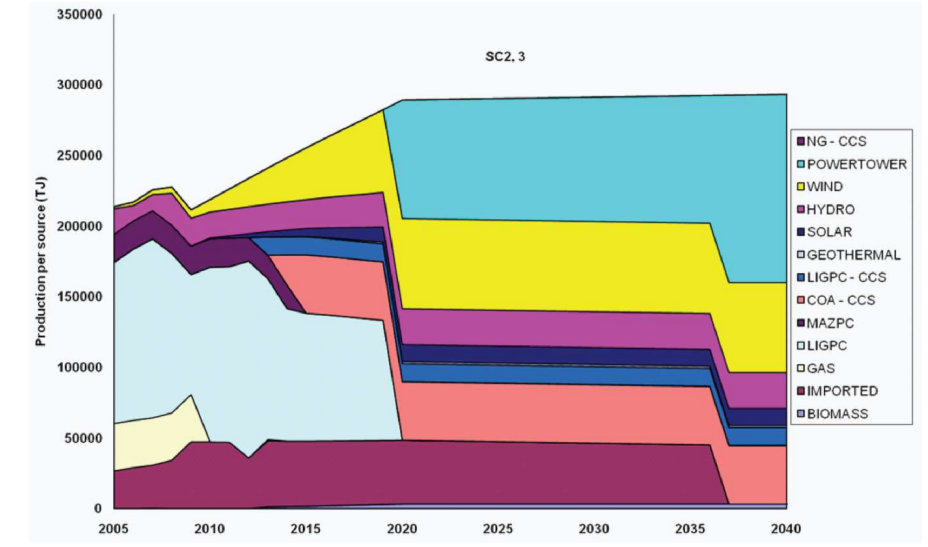
Figure 15. Electricity generation by technology groups according to scenarios SC2 and